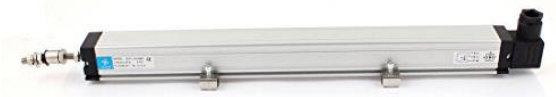
Figure 6. Linear potentiometer model: Uxcell BWL300MM.